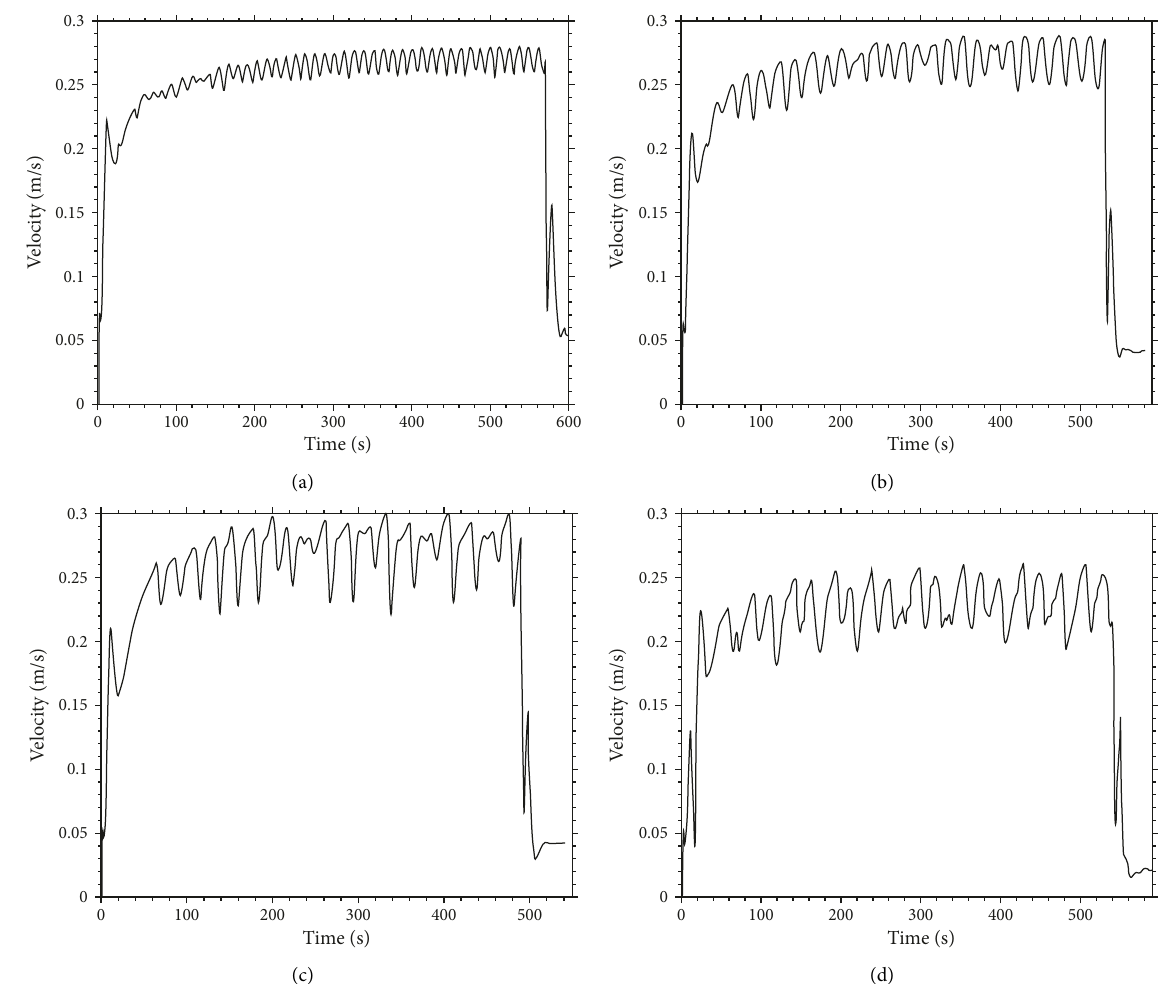
Figure 10: Variation over time of the velocity fields of burned gases near wall. (a) Velocity field during scene 1. (b) Velocity field during scene 2. (c) Velocity field during scene 3. (d) Velocity field during scene 4.